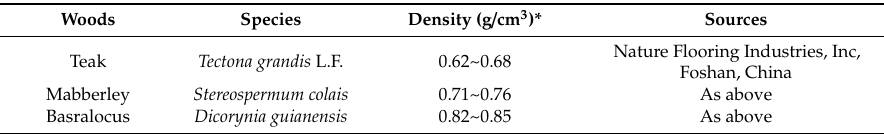
Table 1. Parameters of the wood